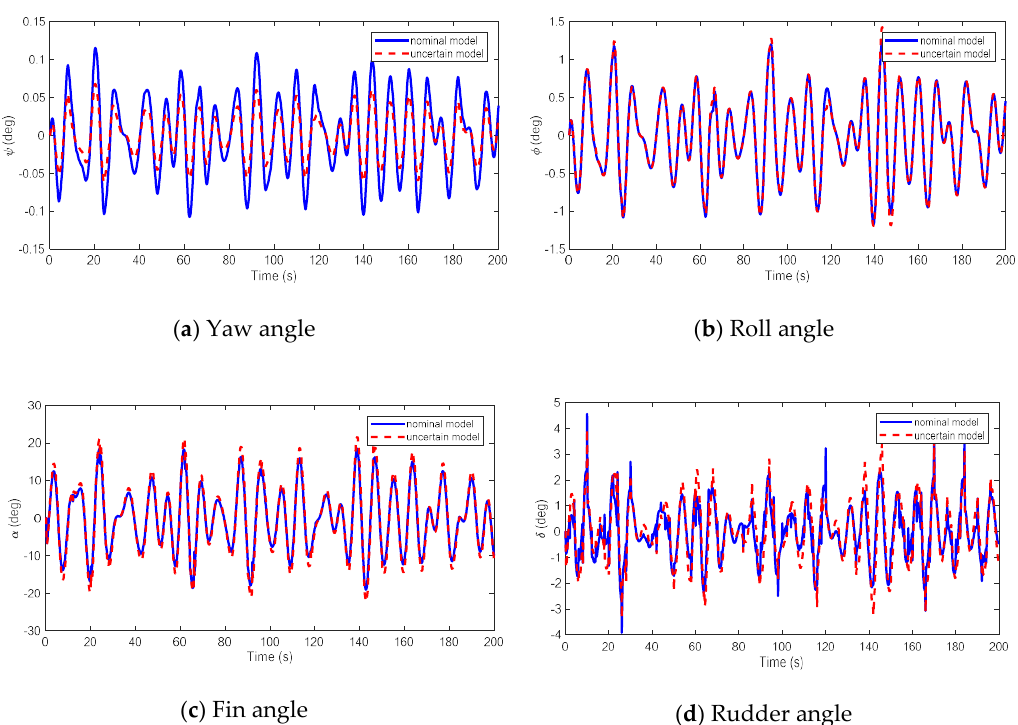
Table 4. Statistical simulation results of the ship roll/yaw motions based on nominal/uncertain model at the encounter angle of 90°. Figure 7. Simulation curves of the ship roll-yaw motions using H ∞ -SFMPC control law based on nominal/uncertain model.